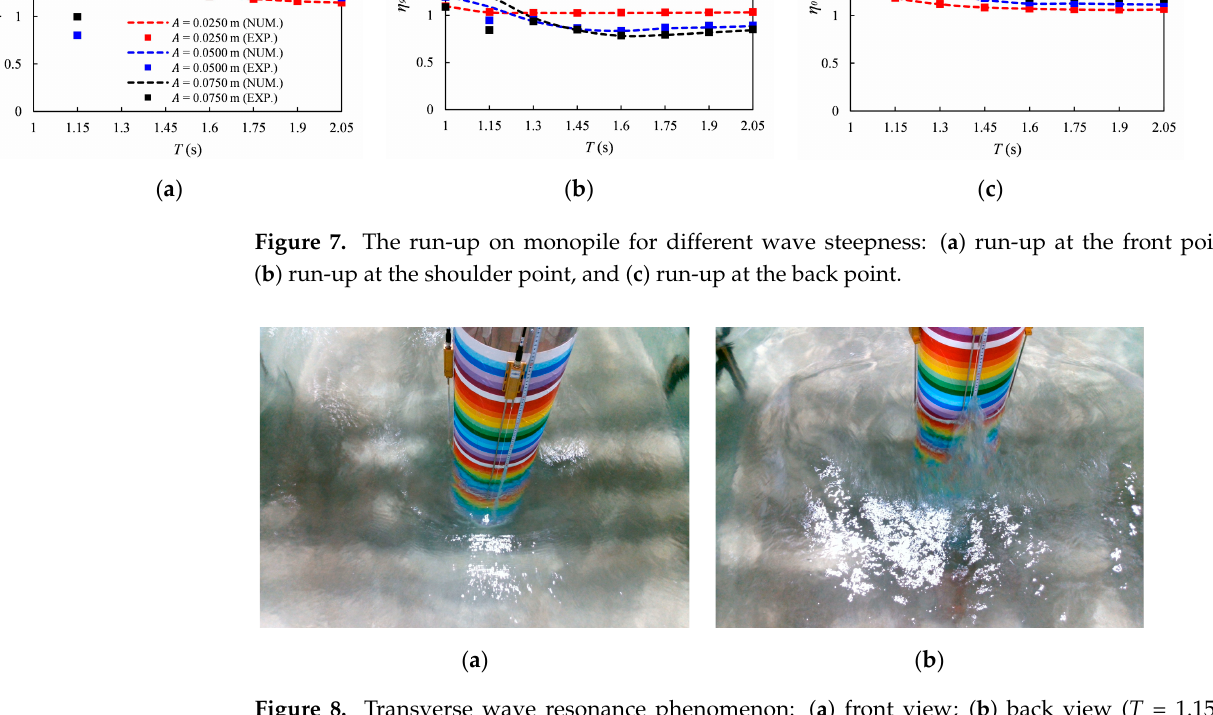
Figure 8. Transverse wave resonance phenomenon: ( a ) front view; ( b ) back view ( T = 1.15 s, A = 0.075 m).